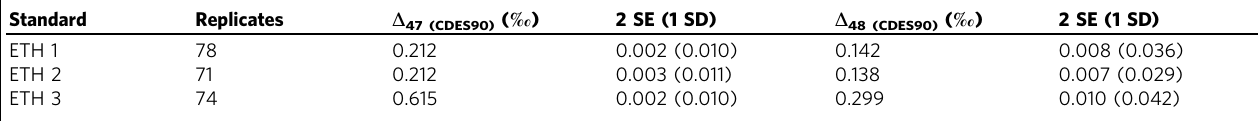
Table 1 Long-term Δ 47 (CDES90) and Δ 48 (CDES90) values of carbonate reference materials. Standard